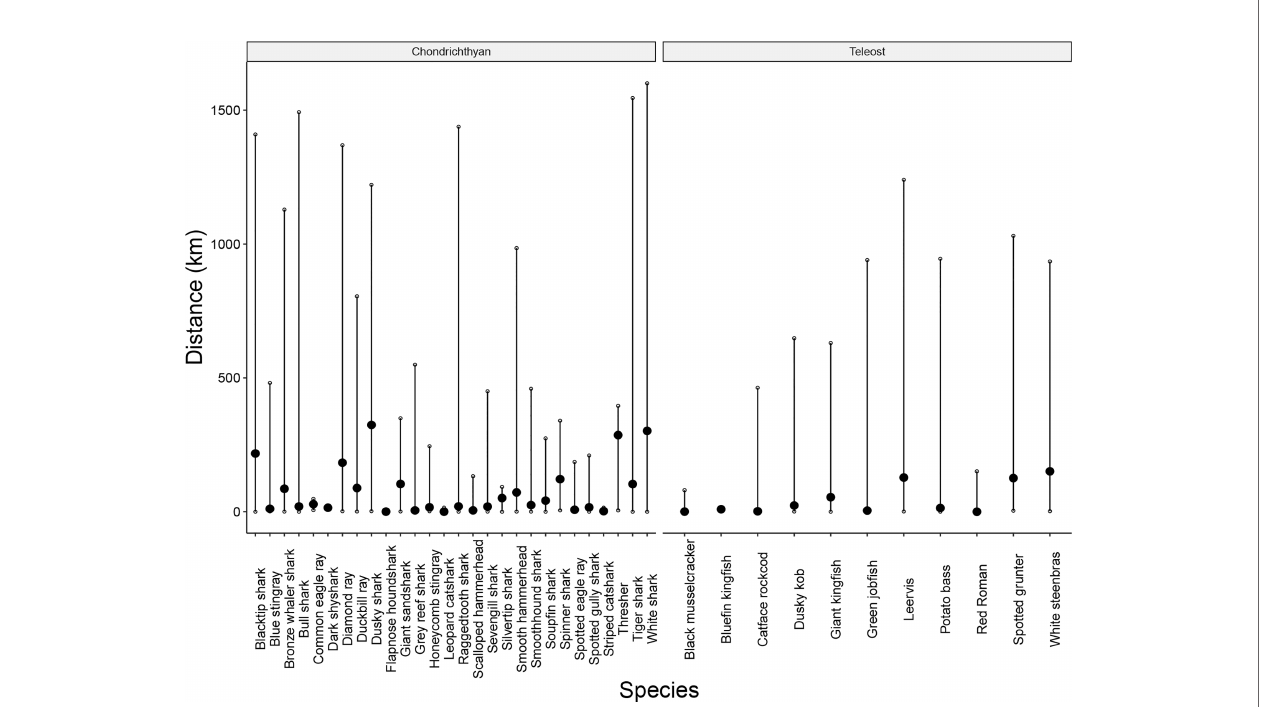
FIGURE 7 | Average distance moved from tagging location (black circle, with con fi dence intervals indicating minimum and maximum distances) per species monitored by the ATAP between 2011 and 2021. Only chondrichthyans and teleosts were considered for this